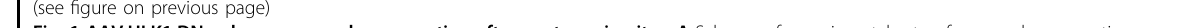
Fig. 1 AAV.ULK1.DN enhances axonal regeneration after axotomy in vitro. A Scheme of experimental setup for axonal regeneration assays in micro fl uidic chambers. DOP: day of preparation of E18 rat cortical neurons and seeding in micro fl uidic culture platforms; DIV: day in vitro; AAV: transduction with adeno-associated viral vectors; IMG: imaging. B Representative images of axons growing in micro fl uidic culture platforms after transduction with viral vectors. Photos were taken directly before axotomy (0 min) to quantify the number of axons before lesion. Images taken 5 min after lesion show successful axotomy (white dashed line). Axons were imaged 24 – 96 h after axotomy to quantify axon regeneration. Note that for AAV.ULK1.DN, for the 5 min and 24 h time points, the imaged area distal to the longest axon covered a smaller area than the images for the other time points. For visualization purposes, the blank area was fi lled with gray color. No axons were added or removed. Scale bar: 100 µm. C – F Quanti fi cation of the relative number of regenerating axons (the number of axons at a given time point divided by the number of axons before axotomy) in cells transduced with AAV.CTRL or AAV.ULK1.DN at the indicated distances from the microgroove exit and 24 – 96 h after axotomy ( n = 4 independent cultures). Data are presented as means ± SEM; * P < 0.05, ** P < 0.01, *** P < 0.001, # P = 0.053, according to two-tailed unpaired t -test for each distance.